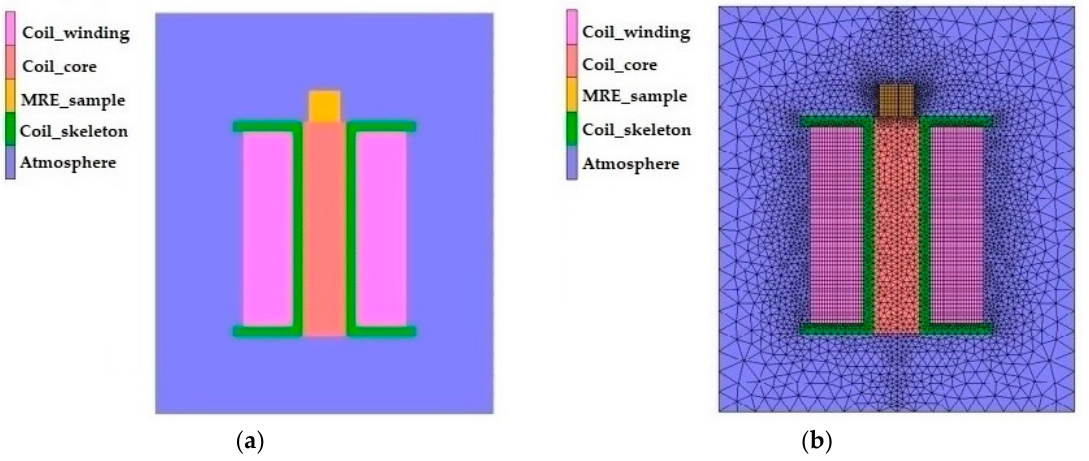
Figure 4. Schematic presentation of the magnet with the MRE sample position on the top of the magnetic and respective atmosphere, ( a ) without mesh, ( b ) with mesh.